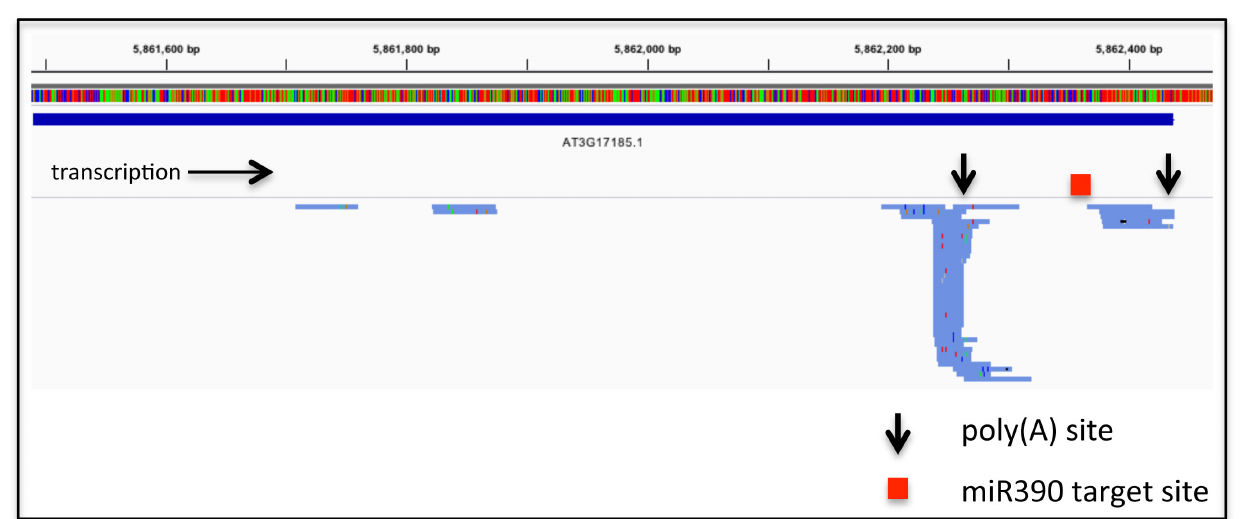
FIGURE 1 |Alternative poly(A) site choice in the gene encodingTAS3a (At3g17185). The bar with the colored vertical lines represents the DNA sequence of the locus, color-coded using the default settings from the Integrated GenomicsViewer (IGV2.0).The extent of the RNA coding region is represented as the solid blue line beneath the sequence. Beneath this are shown the directions of transcription, locations of the two principal poly(A) sites, and the miR390 target site (Allen et al., 2005). Finally, the numerous blue lines below the gray separator represent individual poly(A) tags (taken